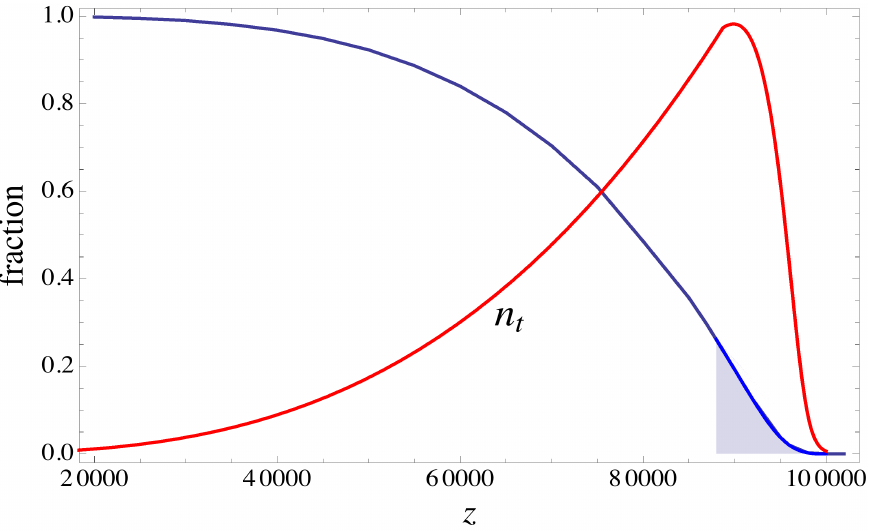
Figure 6. A plot of the fraction of integrated tresino number density (blue curve) and the tresino density (red curve) through the transition. The shaded zone is the region of the rotor production averaging (see the